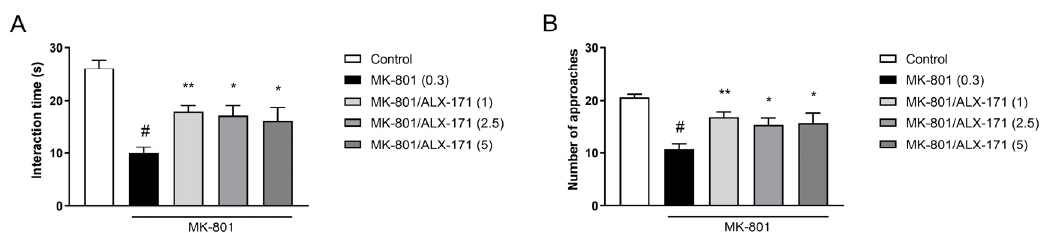
Figure 9. The effect of ALX-171 on MK-801-induced deficits in the social interaction test. Doses are indicated in parentheses as mg/kg. The data are presented as means ± SEM. One-way ANOVA: ( A ) interaction time F (3.38) = 5.346, p < 0.02; ( B ) number of approaches F (3.38) = 4.871, p < 0.006; * p < 0.05; ** p < 0.01 vs. MK-801-treated group; ( A ) # p < 0.01, ( B ) # p < 0.0001 vs. control group.